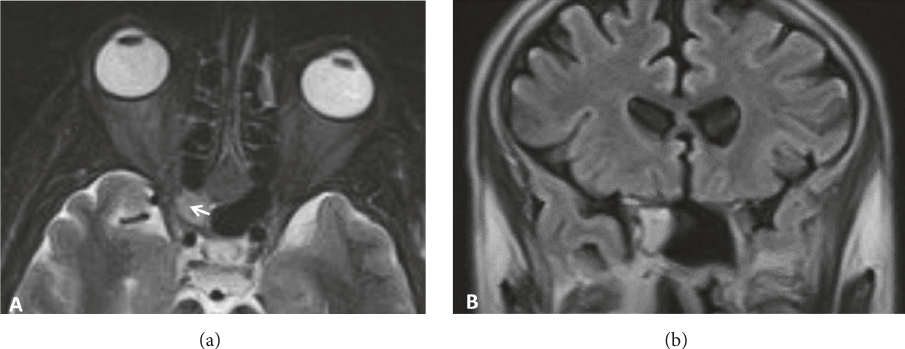
Figure 1: Magnetic resonance images of the brain and orbits. (a) Axial STIR T2W showed questionable mucocele of the right sphenoid sinus or sphenoidal sinusitis (white arrow) but the architecture of the optic nerve was not well defined. (b) Coronal FLAIR T2W showed right sphenoidal pathology but the right optic nerve was not well delineated.